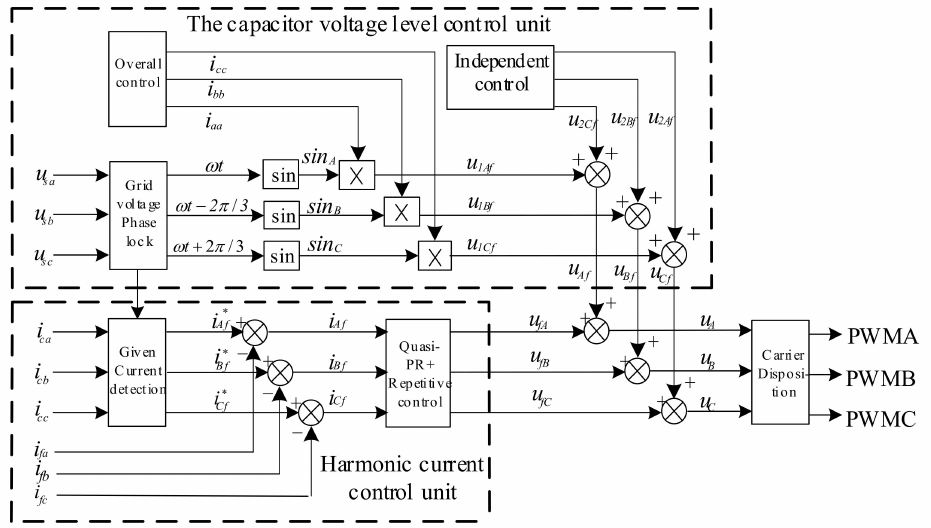
Figure 2. Global control strategy of the system.